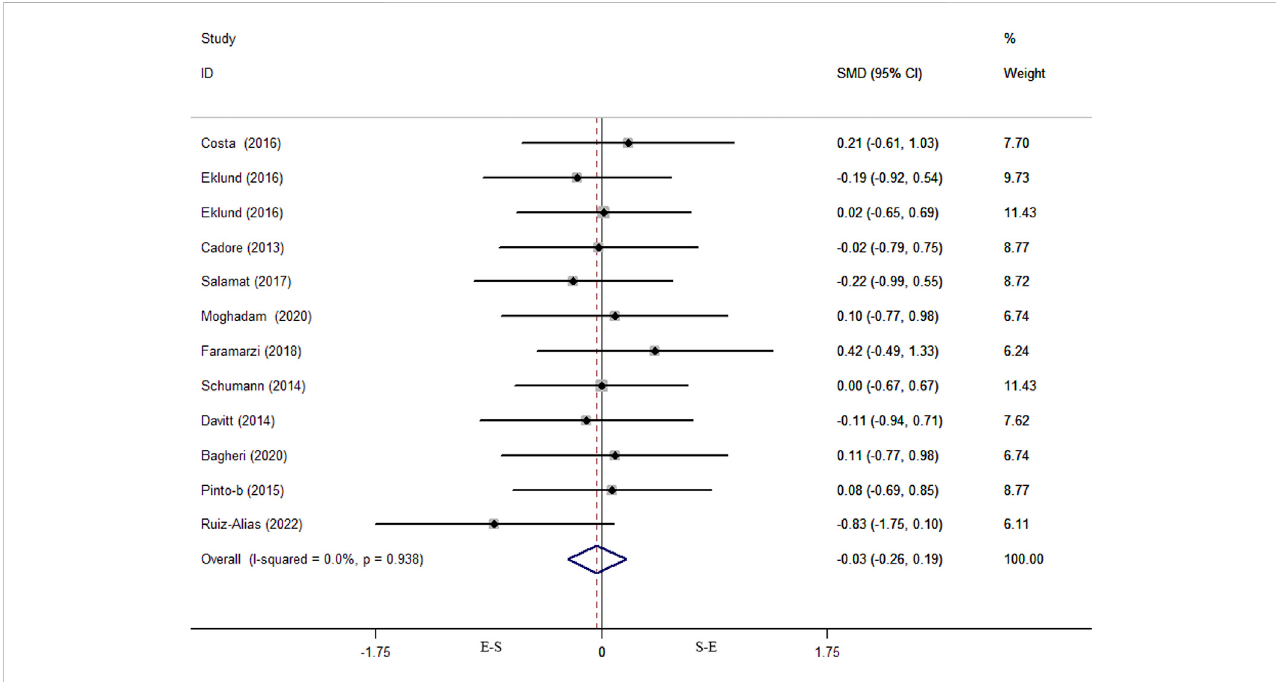
FIGURE 3 Forest plot of effects of concurrent training sequence on VO 2max .